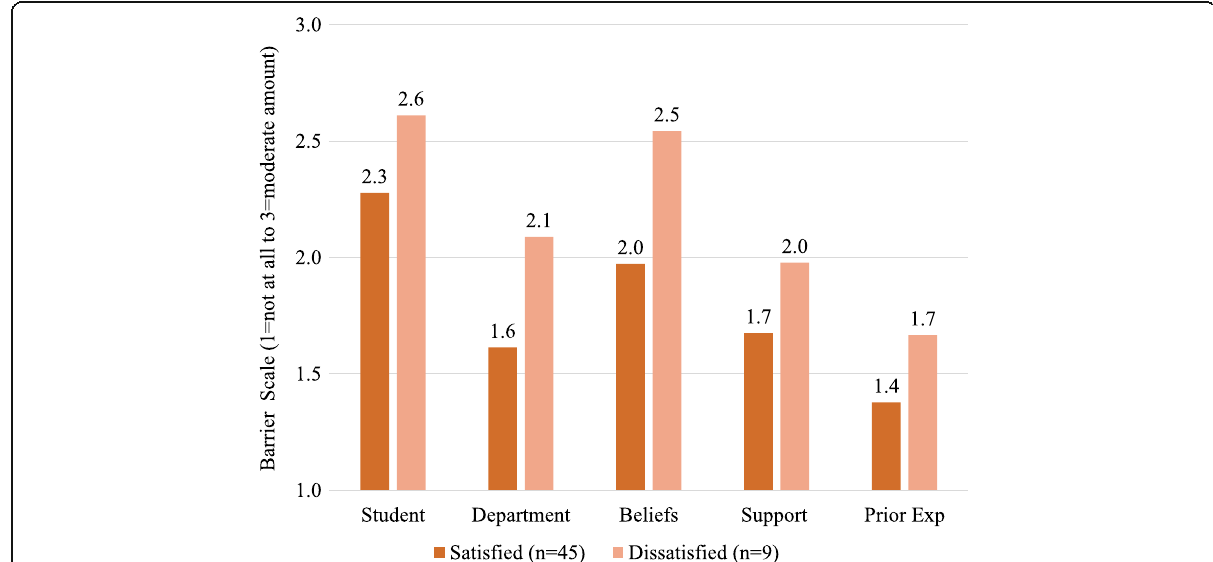
Fig. 3 Descriptive differences in perceived barriers for participants who were satisfied and dissatisfied with their use of collaborative